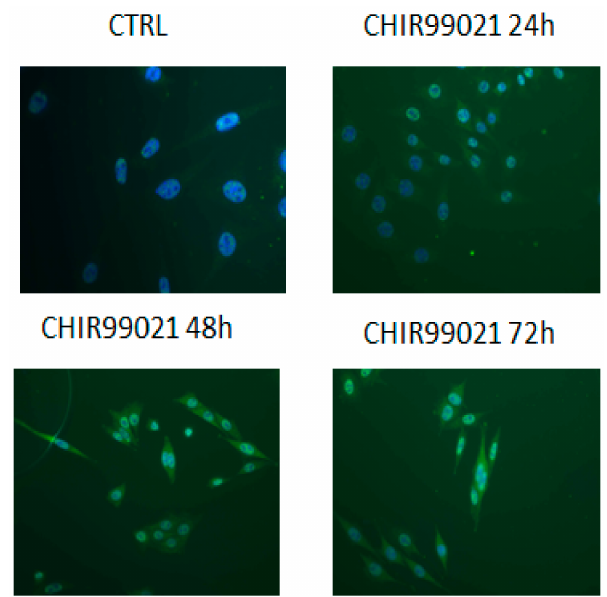
Figure 4. Cells treated with CHIR99021 at 100 nM for 24, 48, and 72 h were stained with β -catenin antibody and revealed by FITC(Fluorescein-5-isothiocyanate)conjugated secondary antibody. Magnification is 40 ×